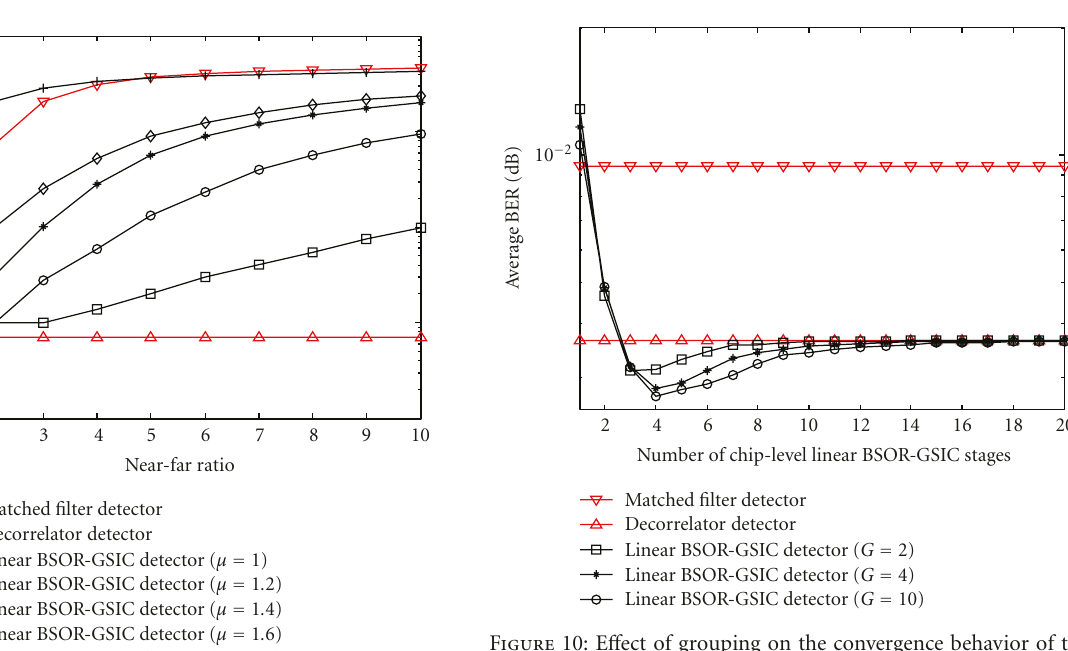
Figure 10: E ff ect of grouping on the convergence behavior of the BSOR-GSIC detector.